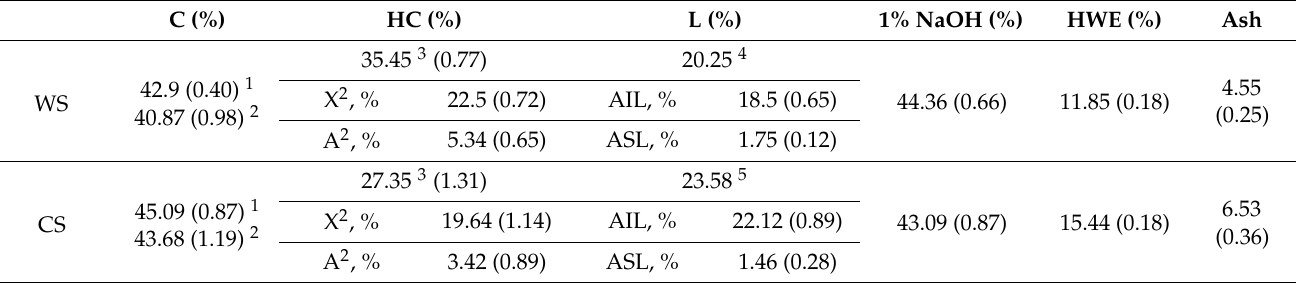
Table 2. Chemical compositions of WS and CS used as raw materials for the HAE of